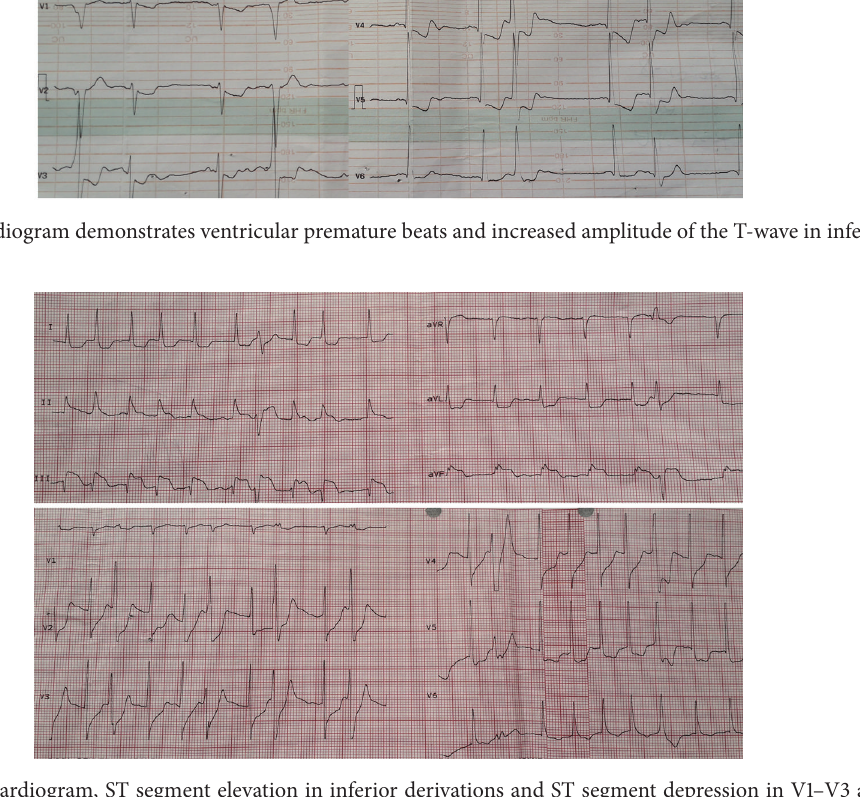
Figure 2: At this electrocardiogram, ST segment elevation in inferior derivations and ST segment depression in V1–V3 are seen with the rhythm of atrial